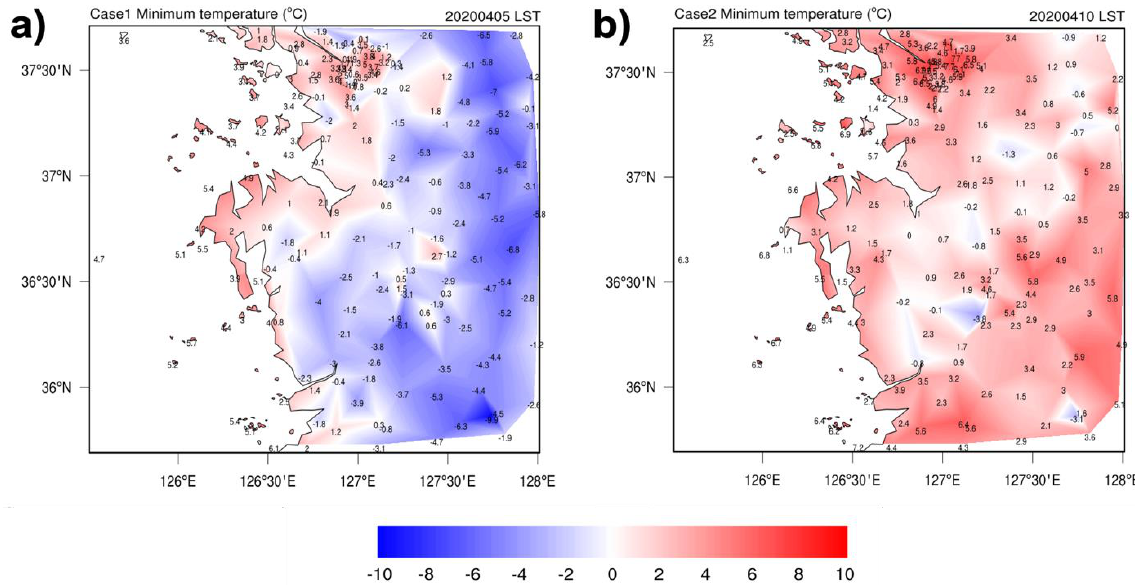
Figure 5. Daily minimum temperature (°C) on ( a ) 5 April 2020 (Case 1) and ( b ) 10 April 2020 over the study domain (Case 2).